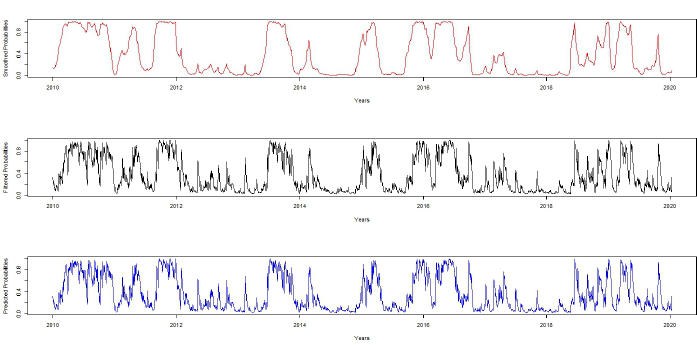
Figure 3. Smoothed, Filtered and Predicted